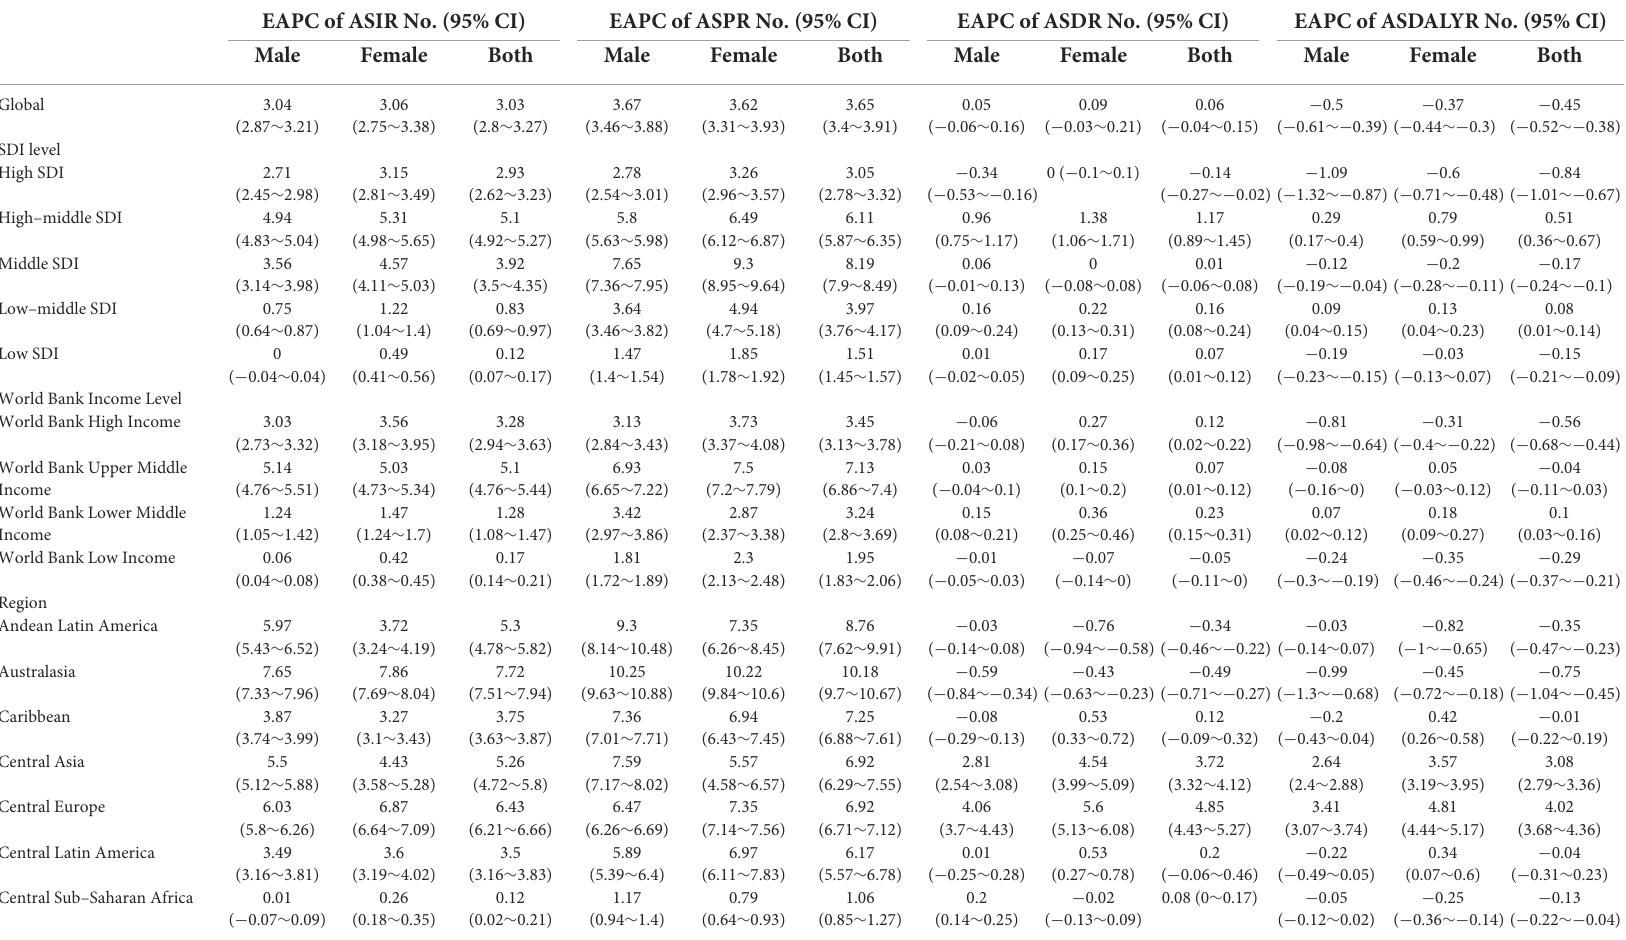
TABLE 5 The temporal trends of ASIR, ASPR, ASDR, and ASDALYR from 1990 to 2019 of CAVD. EAPC of ASIR No. (95% CI) EAPC of ASPR No. (95% CI) EAPC of ASDR No. (95% CI) EAPC of ASDALYR No. (95%